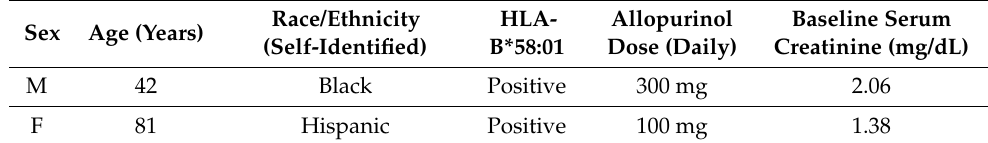
Table 1. Case series of allopurinol DIHS. M—male, F—female.